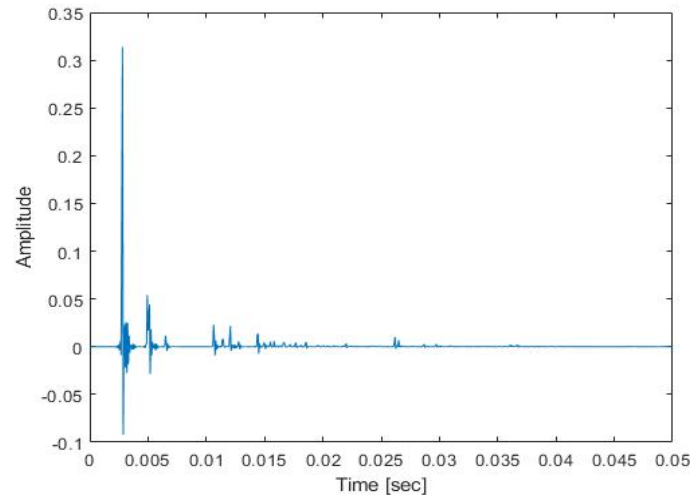
Figure 4. The room impulse response of the experiments.